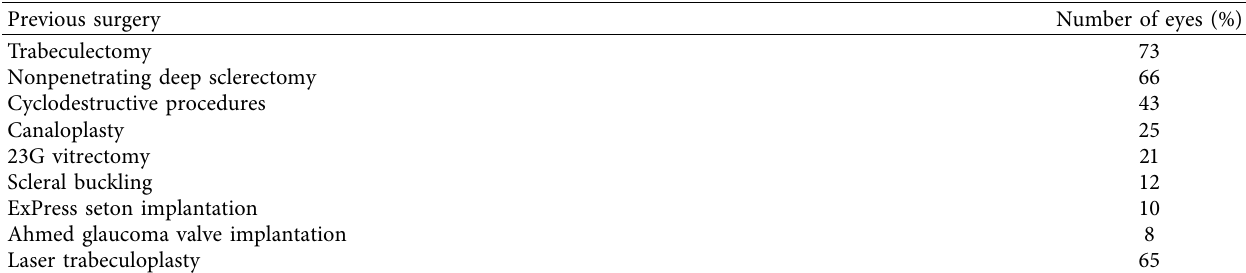
Table 1: Previous surgery